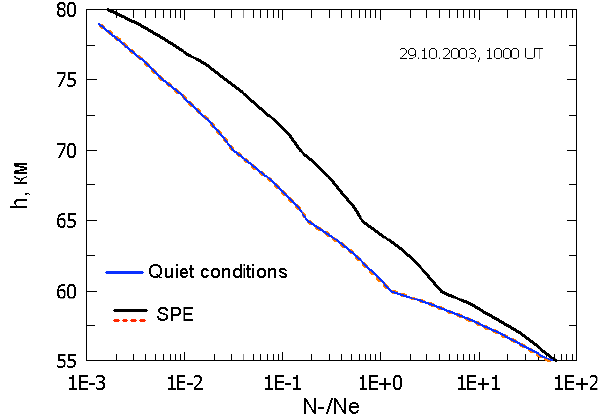
Fig. 8b. λ profiles calculated for quiet conditions (blue curve) using the O, O 3 and NO profiles 1–3 in Fig. 1 and for the SPE on 29 October 2003 at 10:00UT using profiles 4–6 in Fig. 1 (black curve) and 1–3 in Fig. 1 (red dashed curve).